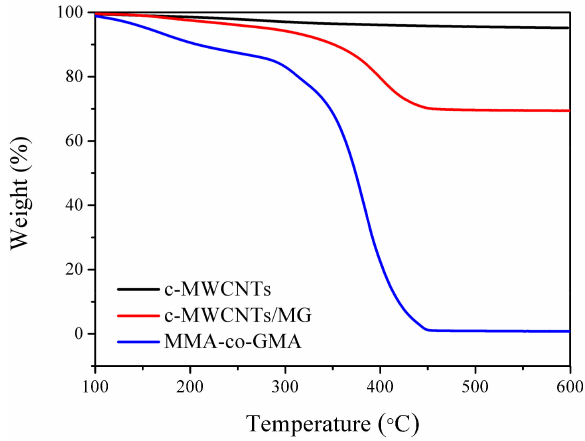
Figure 3. TGA curves of pristine c-MWCNTs, pure MG and c-MWCNTs/MG